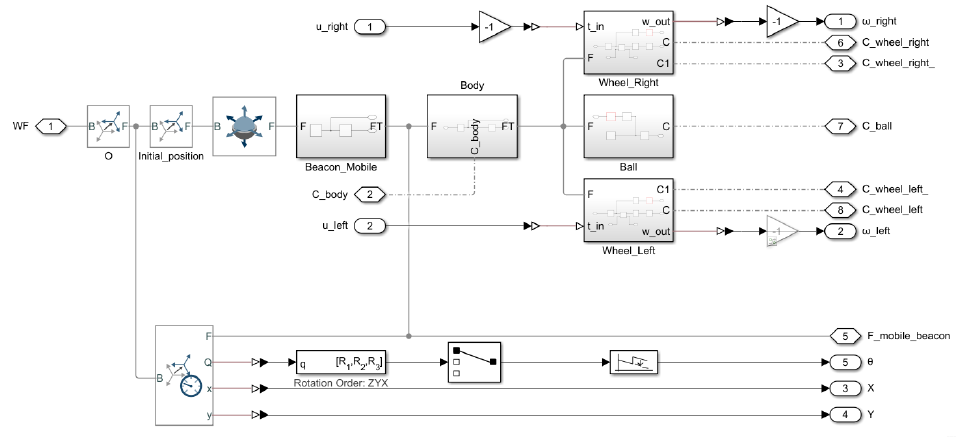
Figure 6. Simscape UGV model.